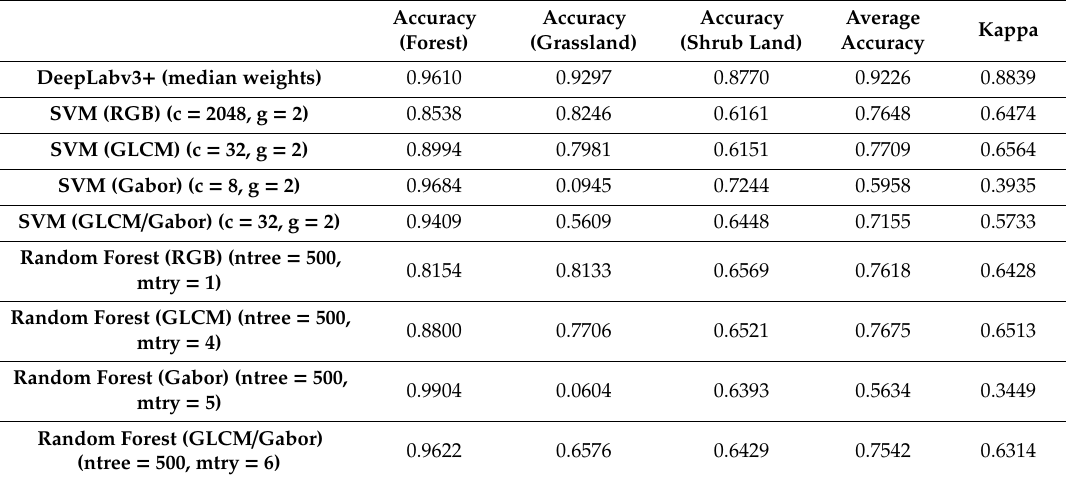
Table 22. Accuracy and kappa values for sampled pixels investigation in Slovenia dataset.